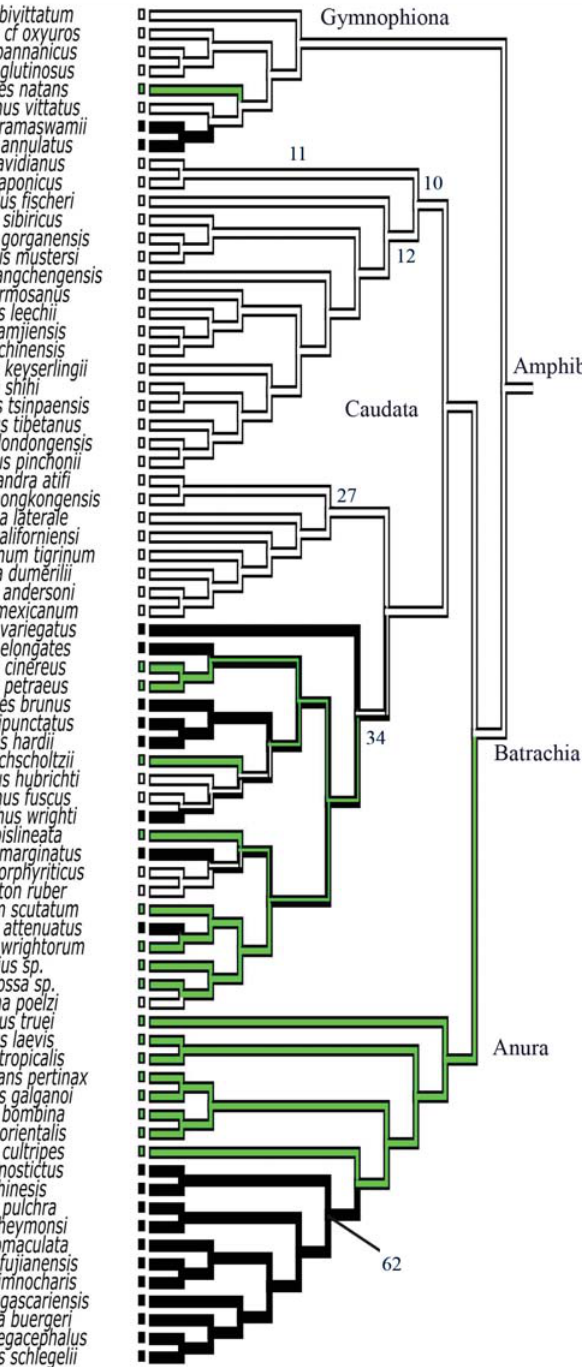
Figure 1 - Phylogenetic relationships of amphibians and history of character evolution. The estimated phylogeny was based on a combination of pub- lished trees of comparative anatomical character evidence, mitochondrial and nuclear DNA sequences (Mauro et al. , 2004; Macey, 2005; Mueller and Boore, 2005; Frost et al. , 2006; Gissi et al. , 2006; Zhang et al. , 2006). The Parsimony reconstruction method was used for the history of characters evolu- tion. The left tree shows the O L thermodynamic stability ( Δ G) with decreasing O L stability being color-coded as follows: violet (most stable), blue, green, yellow and red (least stable). The right tree shows the gene rearrangements, species with gene rearrangements being shown in black, species with partial genome duplications and a genome length > 17 kb being shown in green, while species with “normal” vertebrate gene order are in